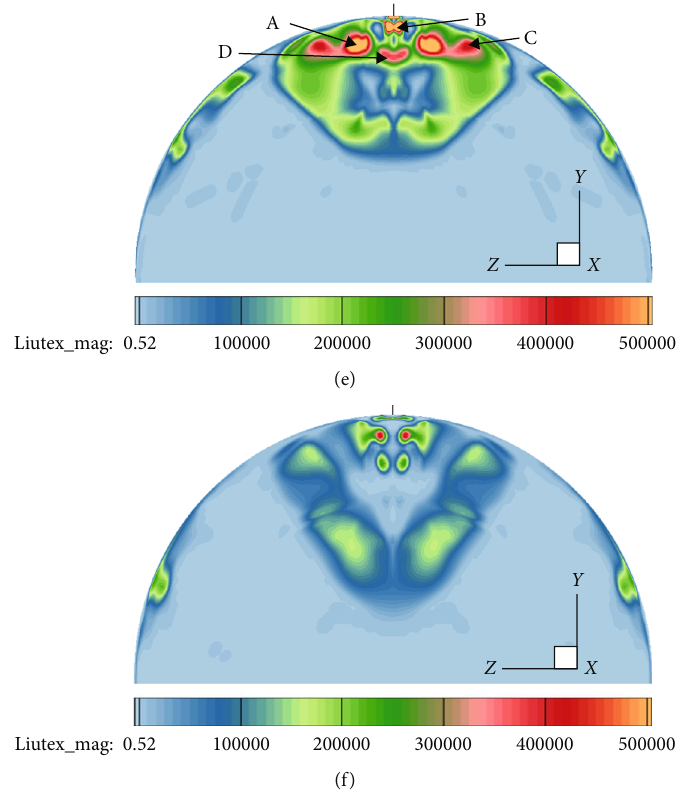
Figure 10: Liutex magnitude contours on di ff erent slices: (a) S1; (b) S2; (c) S3; (d) S5; (e) S6; (f) S7.